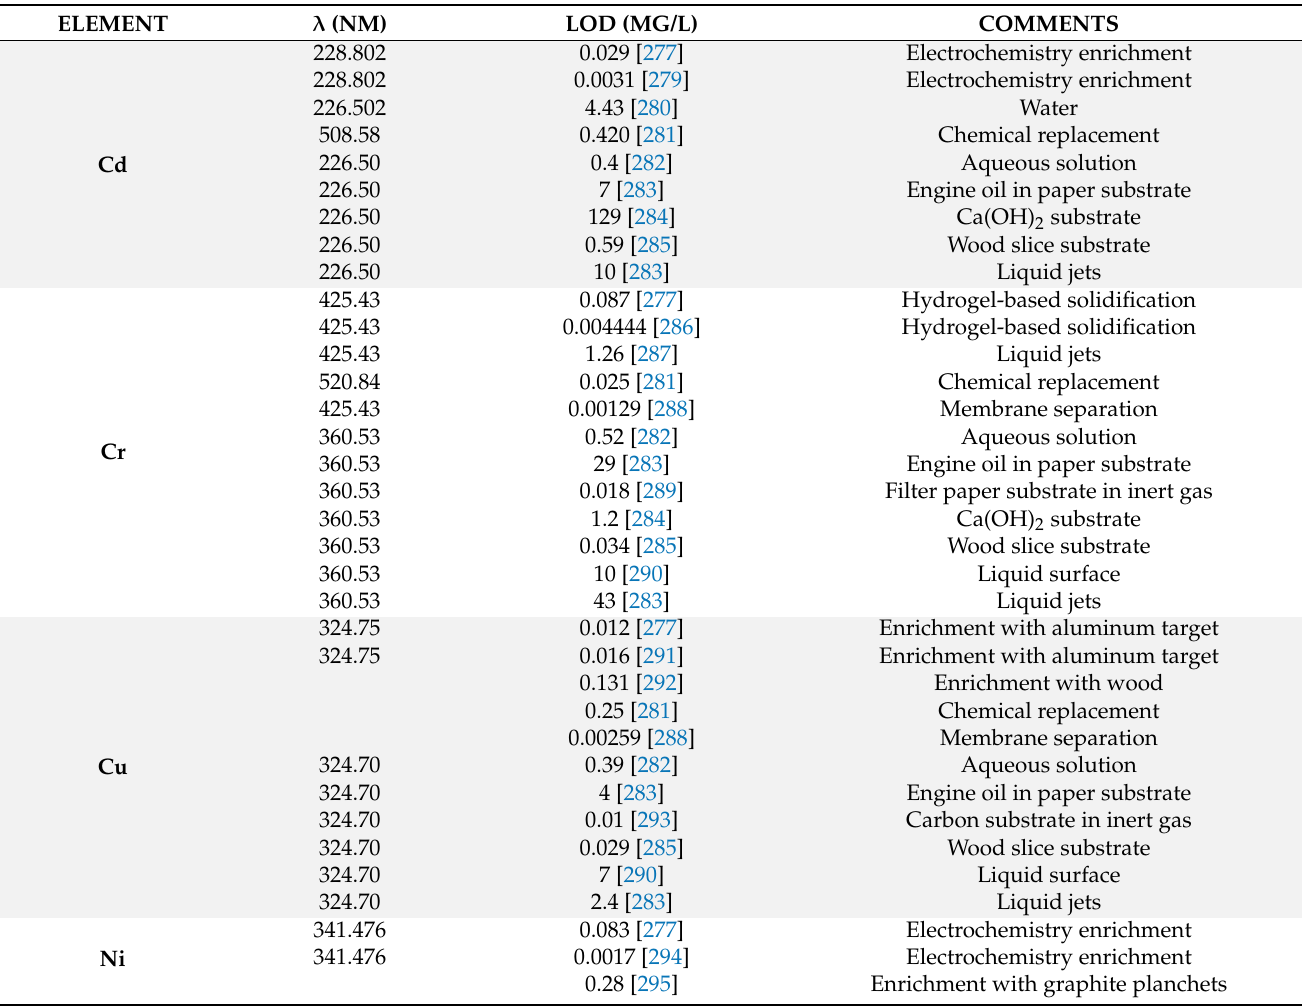
Table 1. Limits of detection by FIPS of metallic ion in aerosol droplets or other